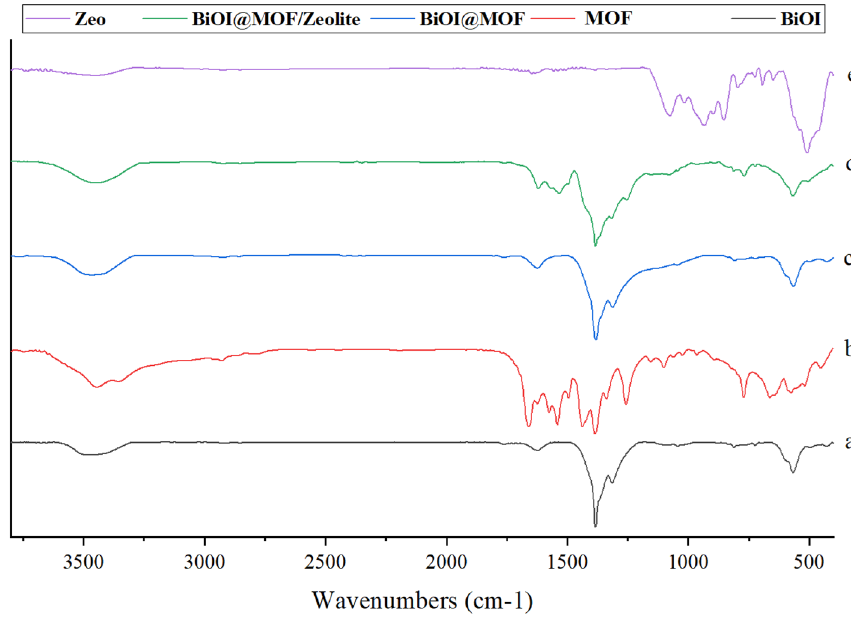
Figure 3. FTIR spectrum of BiOI, MOF, Zeolite, BiOI@MOF and